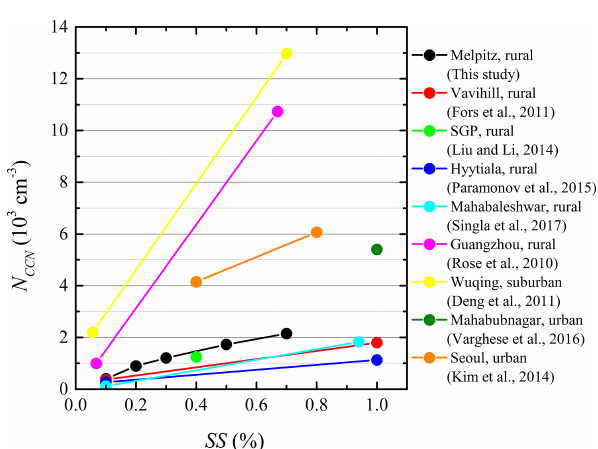
Figure 2. Relationship between CCN number concentration ( N CCN ) and supersaturation (SS) measured at Melpitz and other